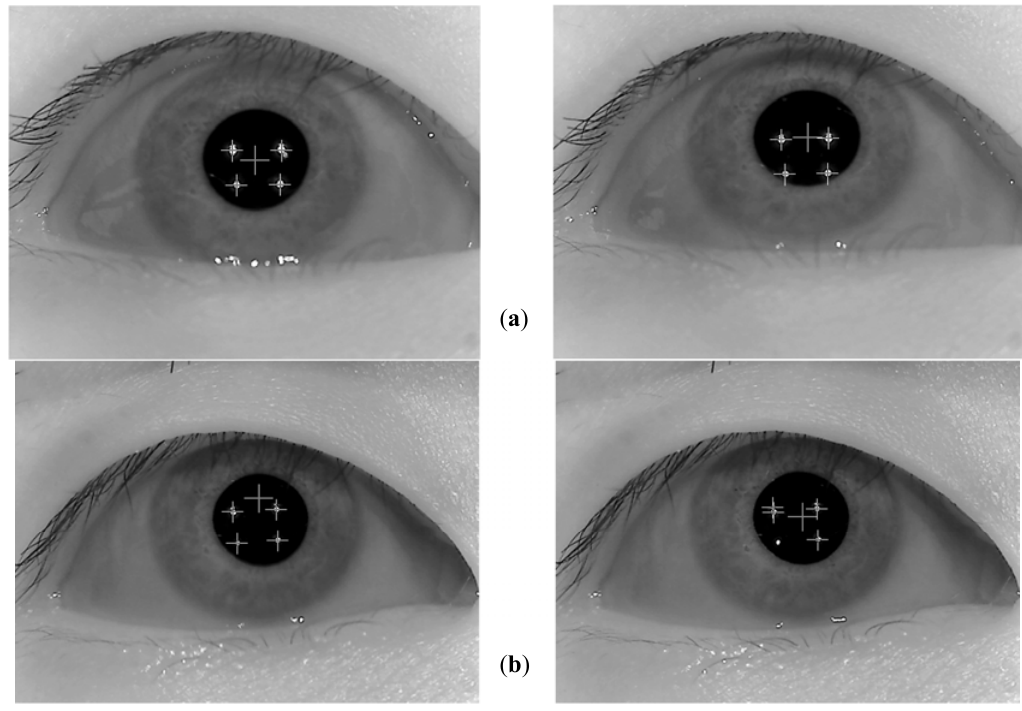
Figure 10. Examples of correct and incorrect detections of pupil center and corneal specular reflection positions. ( a ) The cases of correct detection. ( b ) The cases of incorrect